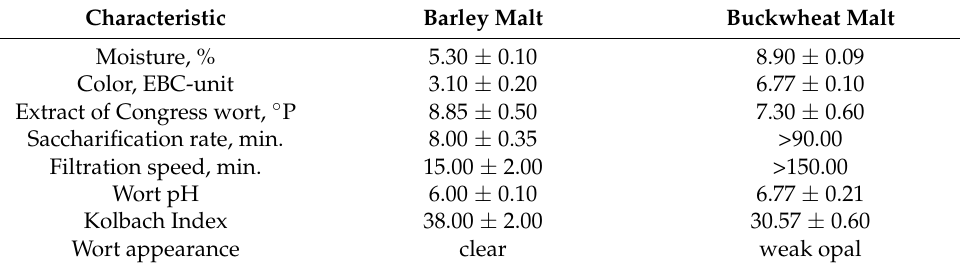
Table 4. Physico-chemical characteristics for barley malt and buckwheat malt.